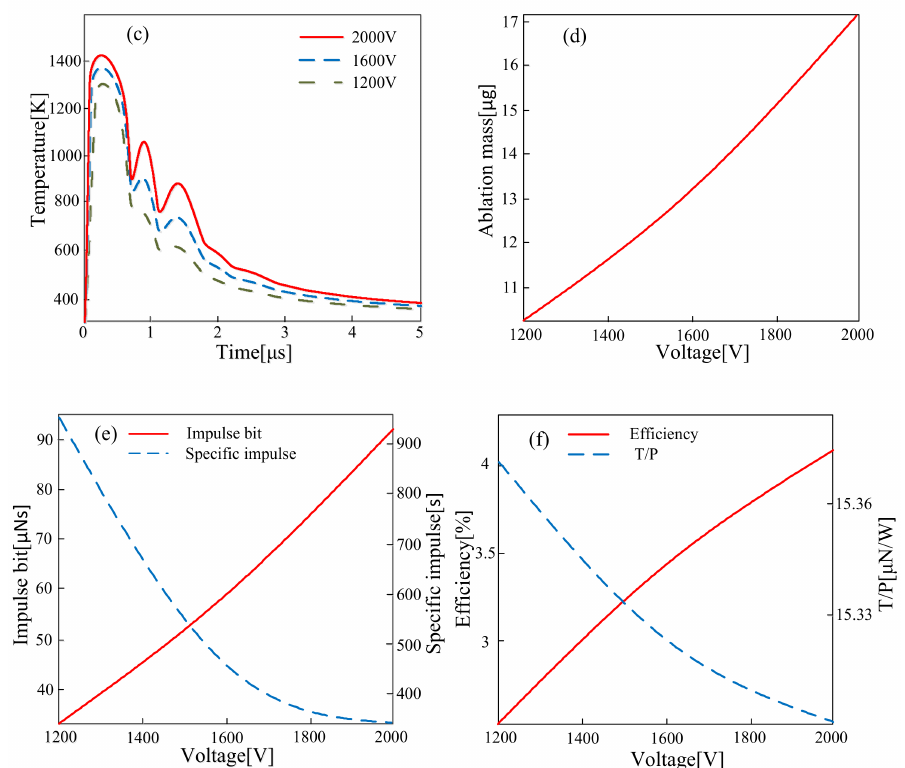
Figure 7. Simulation results at different initial discharge voltages: ( a ) Discharge voltage waveform; ( b ) discharge current waveform; ( c ) variation of ablation surface temperature with time; ( d ) variation of ablation mass with initial discharge voltage; ( e ) variation of impulse bit and specific impulse with initial discharge voltage; and ( f ) variation of efficiency and ratio of thrust to power with initial discharge